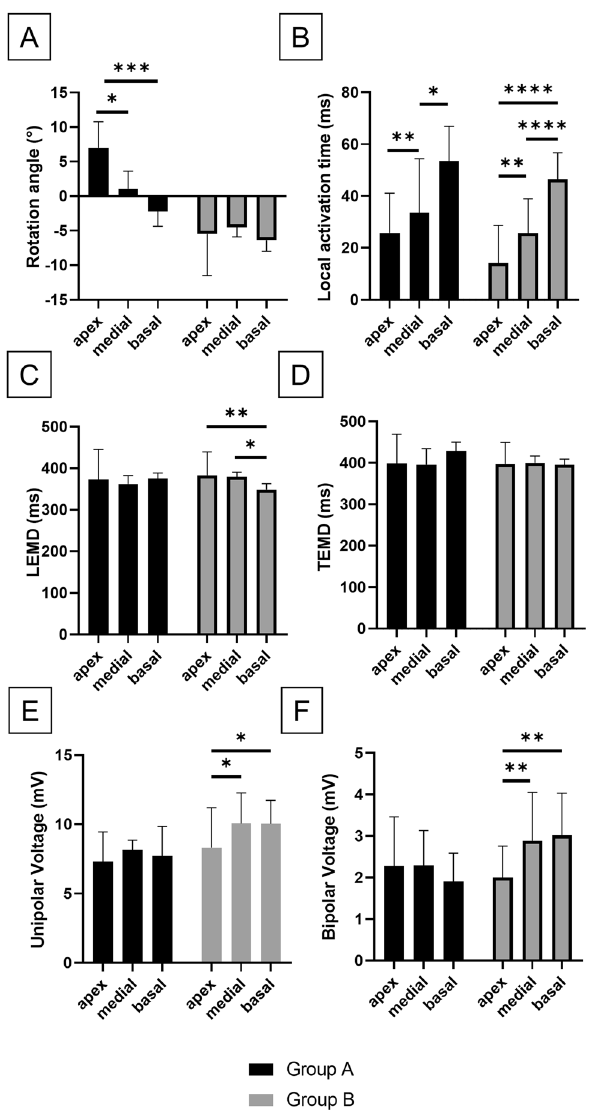
Figure 3. Graphical representation of electro-mechanical parameters statistical comparisons. ( A ) Rotational angle. ( B ) Local activation time. ( C ) LEMD. ( D ) TEMD. ( E ) Unipolar voltage. ( F ) Bipolar voltage. LEMD, Local electromechanical delay. TEMD total electromechanical delay. *p < 0.05; **p < 0.01; ***p < 0.001; ****p <